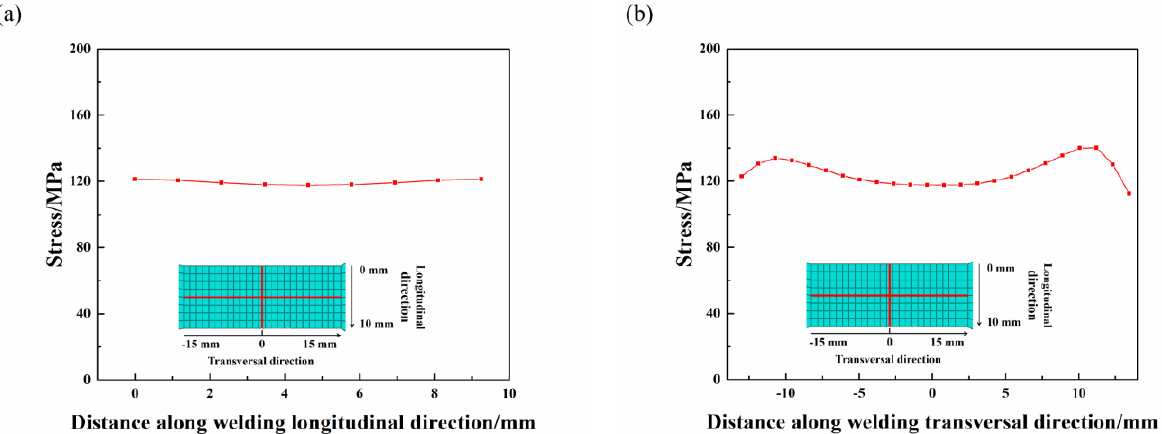
Figure 18. Low-cycle fatigue residual stress of the base metal for ( a ) longitudinal, ( b ) transversal.